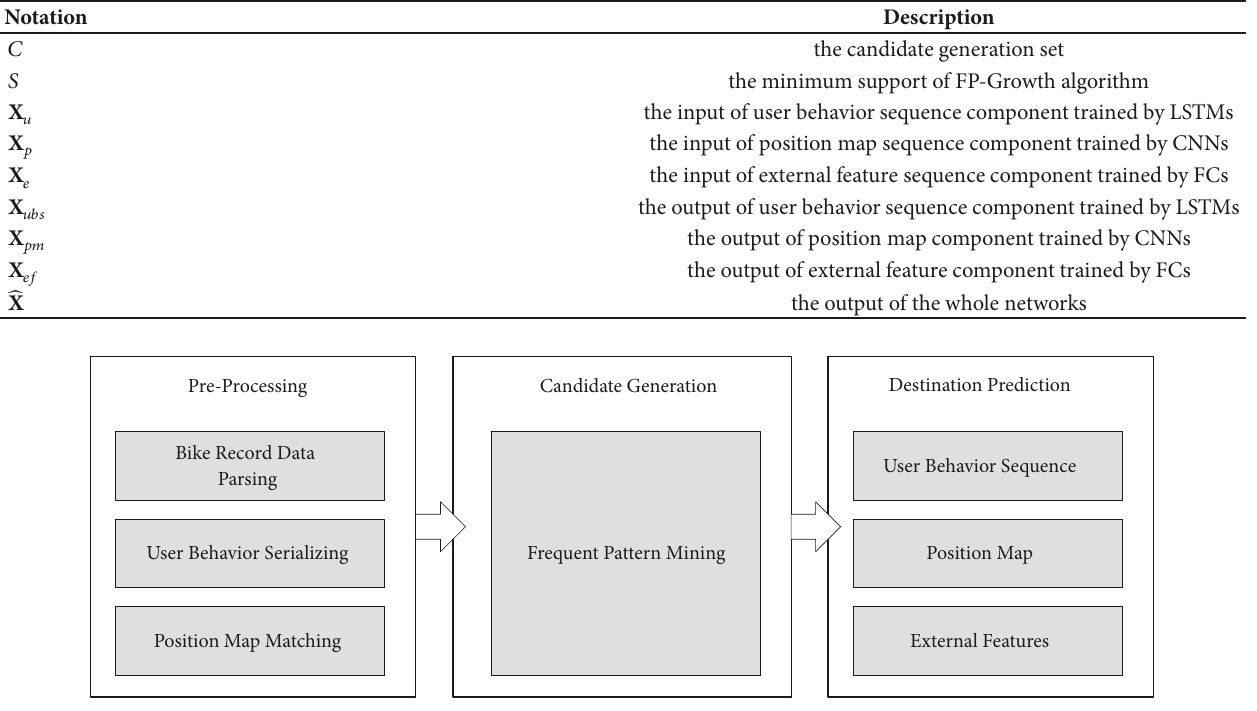
Table 1: Notations in our paper.